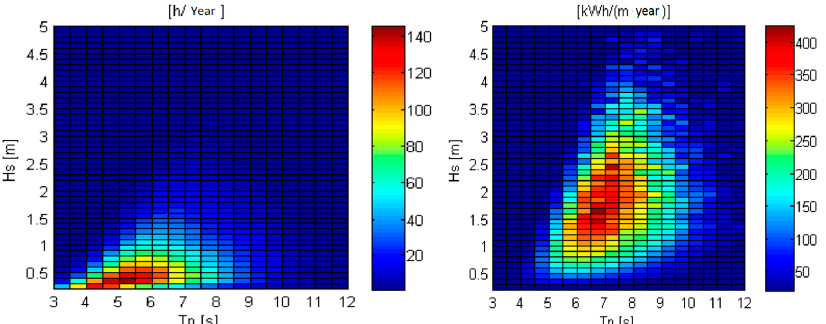
Figure 10. Hourly recurrence and scattering table of extractable energy, measured by Nortek AWAC. obtained from Viola [16], with permission Licensed under CC BY-NC 4.0 from International Journal of Heat and Technology, 2016.